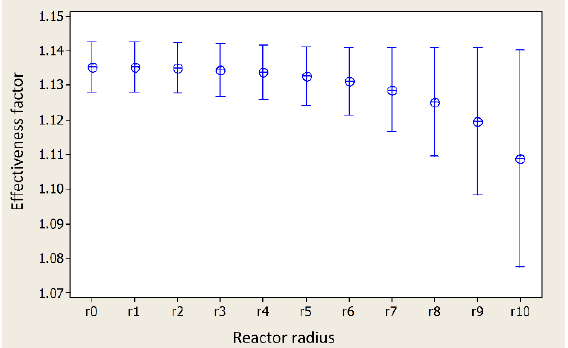
Figure 5. Analysis of variance of the effectiveness factor vs. reactor radius (obtained from Table A4). Interval plot 95% CI for the mean. Interval plot 95% CI for the mean. Table 2. Analysis of variance of the effectiveness factor versus the reactor radius.